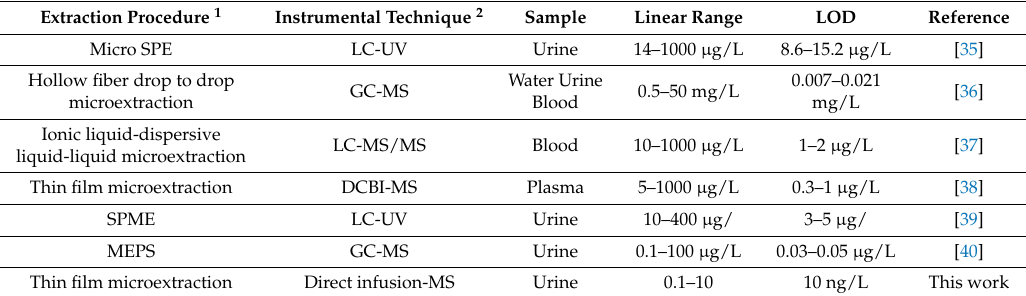
Table 1. Comparison of the sensitivity provided by the new method with other counterparts proposed for the determination of antidepressant drugs in biological